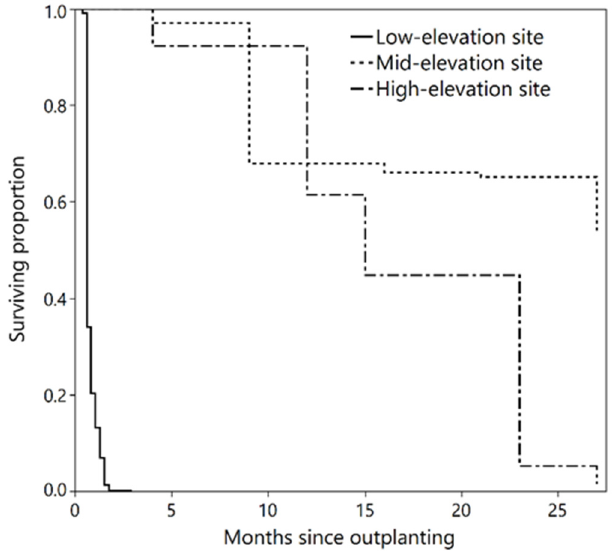
Figure 2. Surviving proportion of ponderosa pine seedlings at the three common garden sites